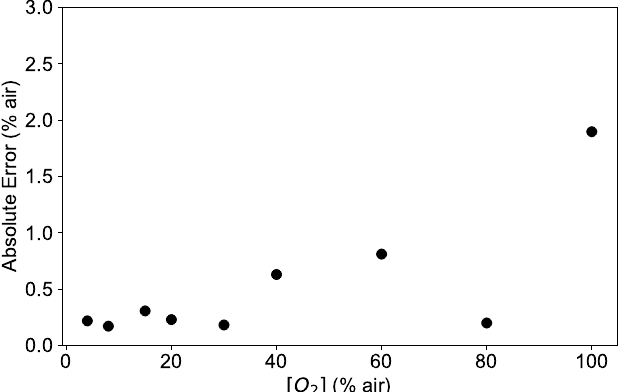
Figure 10. Absolute error (AE) of the neural network model prediction applied to the experimental data at the temperatures 45 ◦ C for a network with 3 layers and 10 neurons.